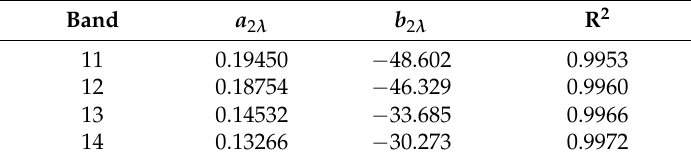
Table 2. The linear fitting coefficients of Planck function for ASTER thermal infrared bands 1